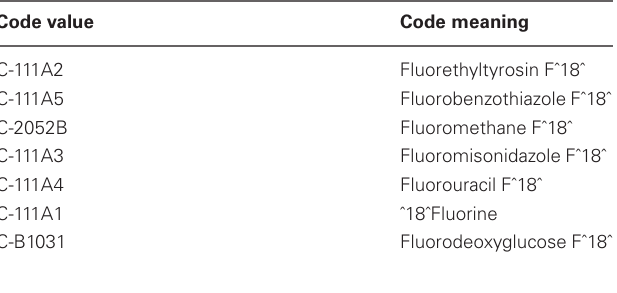
Table 2 | Standard terms for Fluorine radioisotope subtypes from the SNOMED CT terminology.